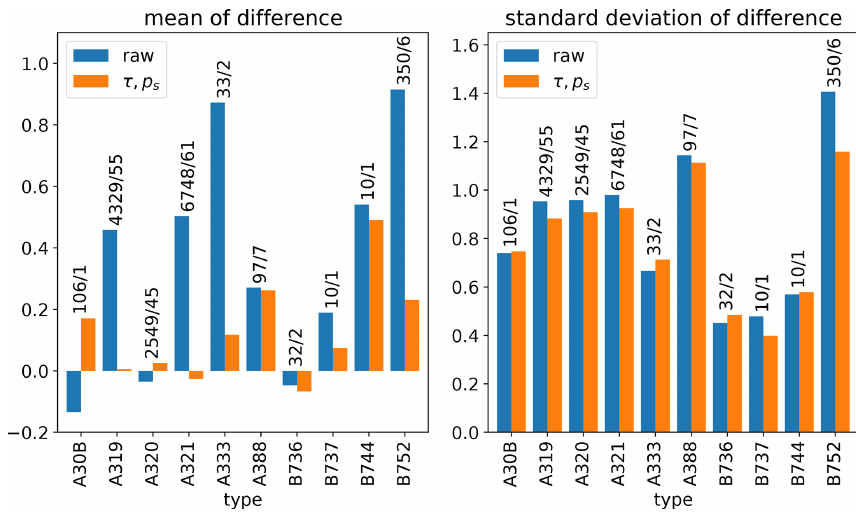
Figure 4. Bias and standard deviation of AMDAR minus radiosonde temperatures, grouped by aircraft type. The two numbers for each group denote the total number of observations and the number of unique aircraft,